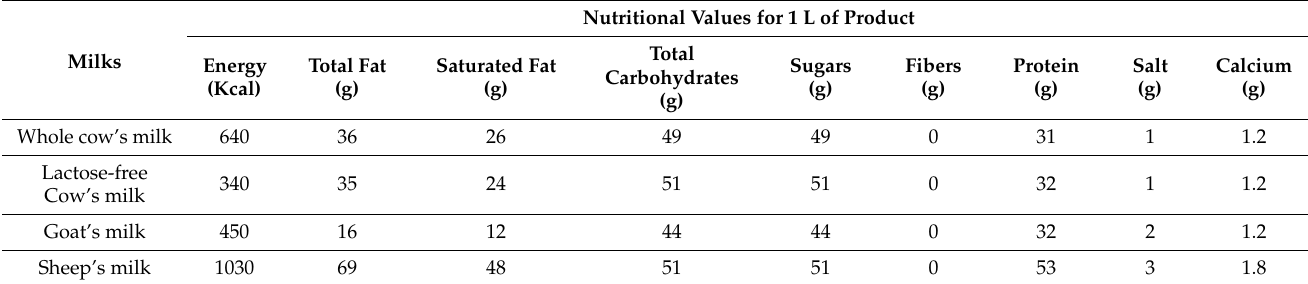
Table 1. Main nutritional characteristics of whole cow’s milk (C), lactose-free cow’s milk (HD), goat’s milk (G), and sheep’s milk (S) used as different matrices for kef í r